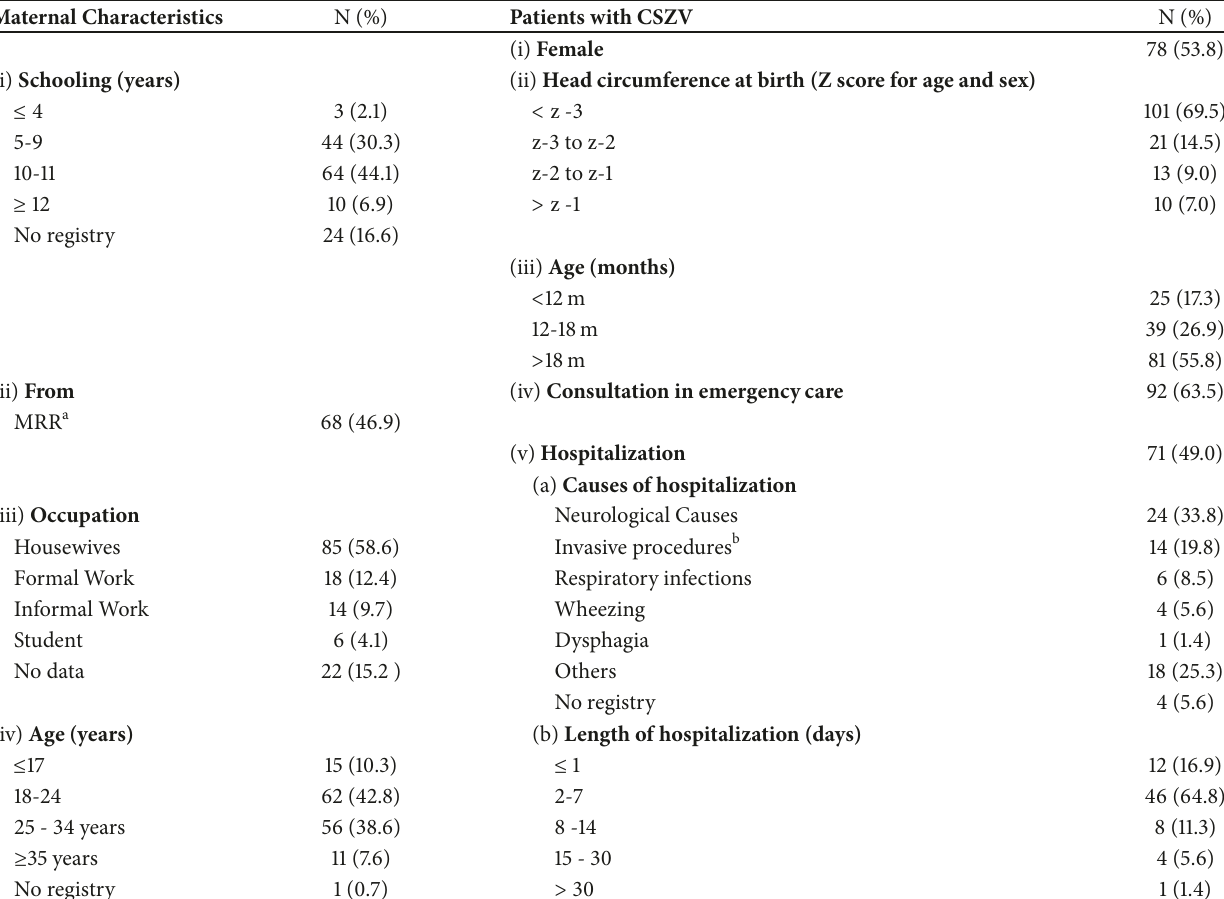
Table 1: Maternal and patients with CZVS characteristics. Institute of Integral Medicine Prof. Fernando Figueira, August 2015 to October